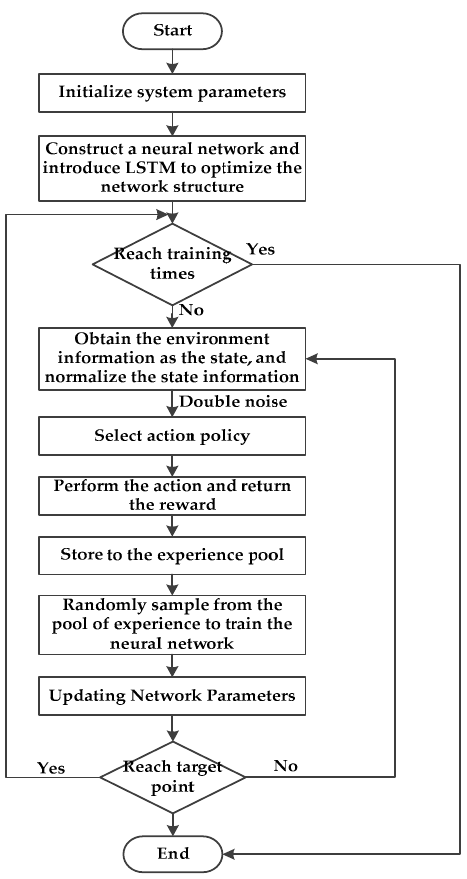
Figure 5. Flow chart of the proposed path planning algorithm.